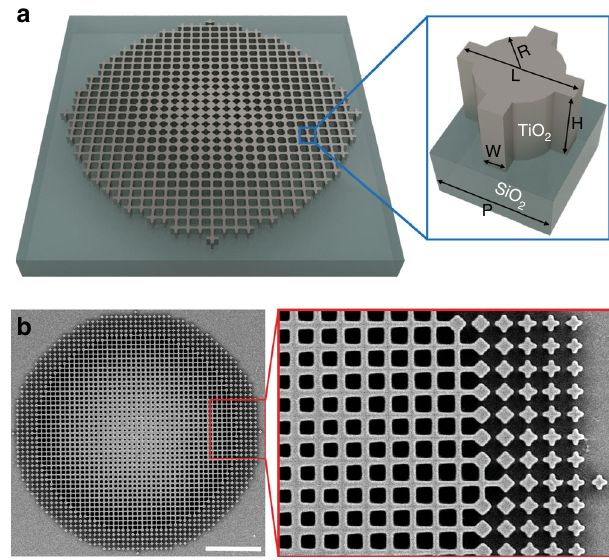
Fig. 1 Schematic and scanning electron micrograph of a fi shnet- achromatic-metalens (FAM). a Schematic of the proposed broadband metalens and its unit-cell with multi-degrees of freedom. The period of the unit-cell (P) is 370nm, the height of the unit-cell (H) is 350nm, and the metasurface is made of titanium dioxide (TiO 2 ). The design parameters are the width of the cross ( W ), the length of the cross ( L ), and the radius ( R ). b Top view of an optical microscope image of a fabricated FAM and zoom-in showing the quality of the fabricated device. The scale bar represents 5 μ